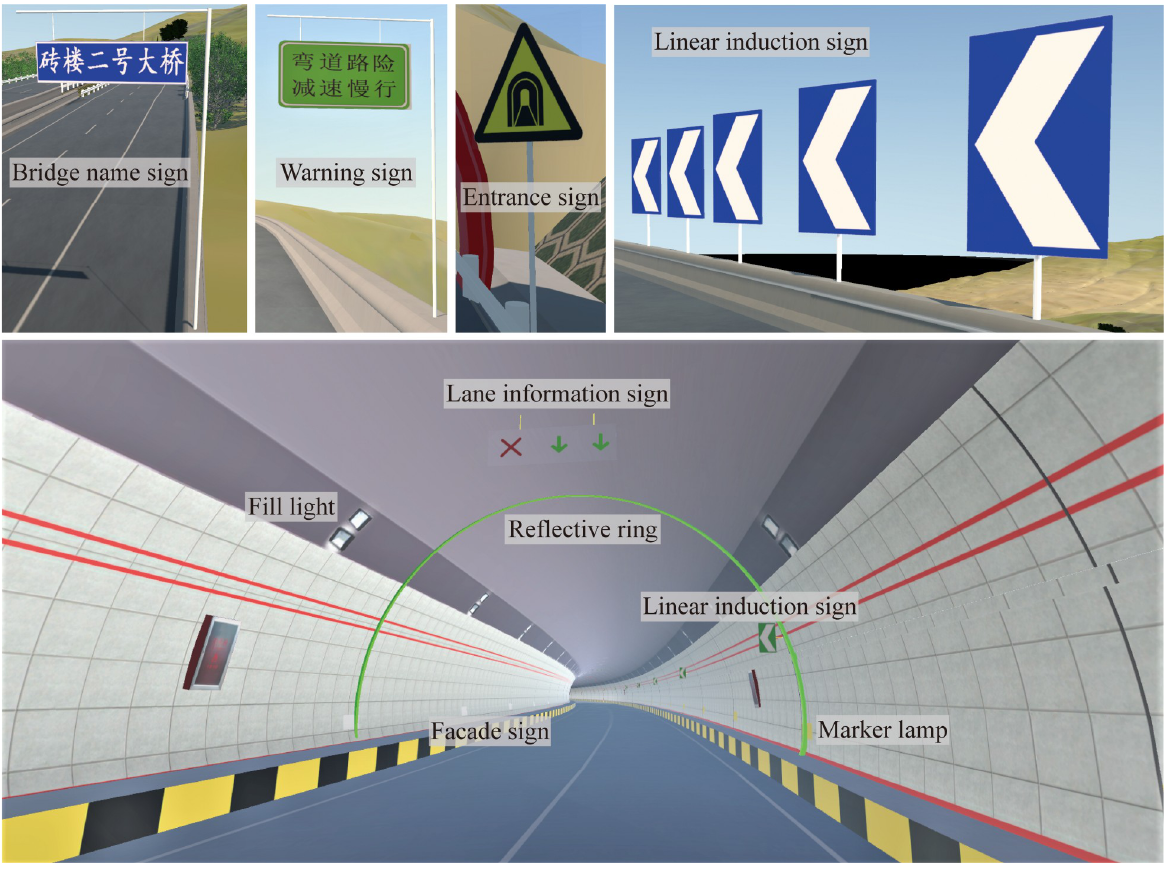
Fig 9. Design and simulation of traffic